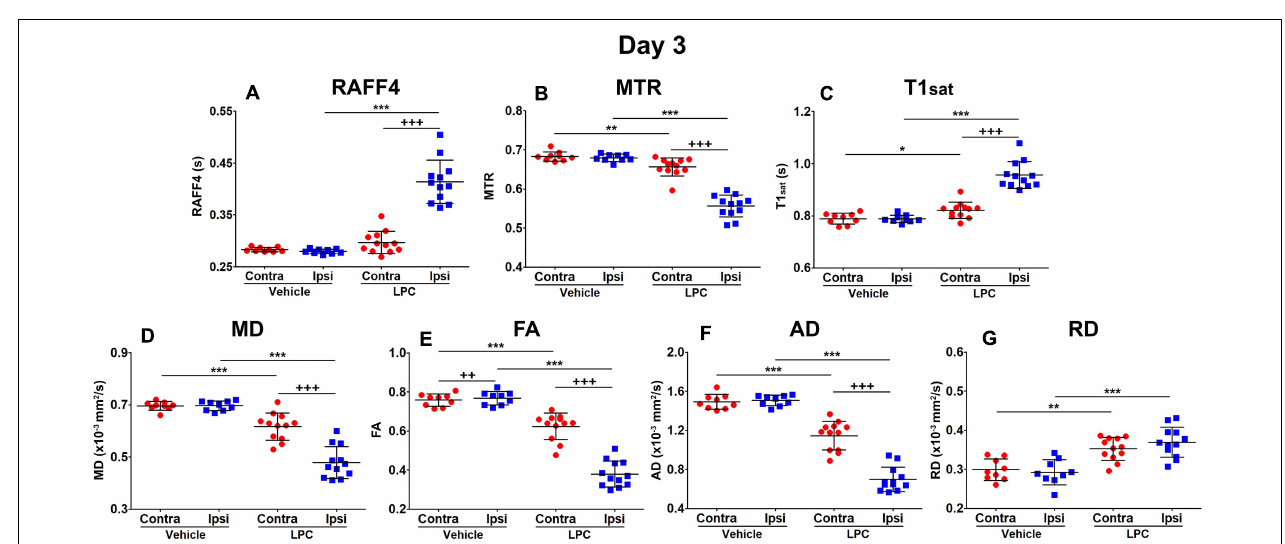
FIGURE 3 | Region of interest analysis of MRI parameters in the demyelination phase, on day 3: RAFF4 (A) , magnetization transfer ratio, MTR (B) , T1sat (C) , mean diffusivity MD (D) , fractional anisotropy, FA (E) and axial and radial diffusivity, AD (F), and RD (G) . Values obtained from the ipsilateral and contralateral sides of LPC injected ( n = 12) rats and from the corresponding ROI in the vehicle injected ( n = 9) rats. Mean ± SD, paired (+) or unpaired (*) t -test, FDR corrected p -values: * < 0.05, ** or ++ < 0.01, *** or +++ <